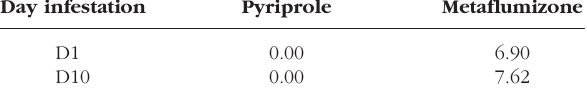
Table II. – Anti-feeding effect (%).